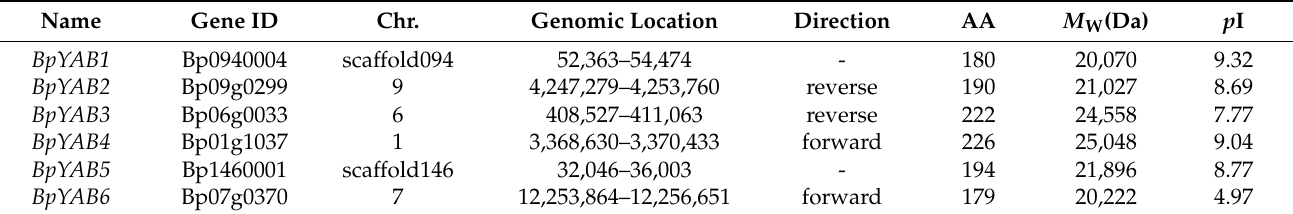
(Figure S1). The directions of BpYAB2 and BpYAB3 were reverse, while BpYAB4 and BpYAB6 were forward in the genome. The molecular weight of BpYAB proteins was between 20 and 25 kD (Table 1), and the predicted isoelectric point of each BpYAB protein ranged from 4.97 to 9.32. The relative genomic locations of the six YABBY members and other information are shown in Figure S1 and Table 1. Table 1. Sequence information of the BpYAB family in paper